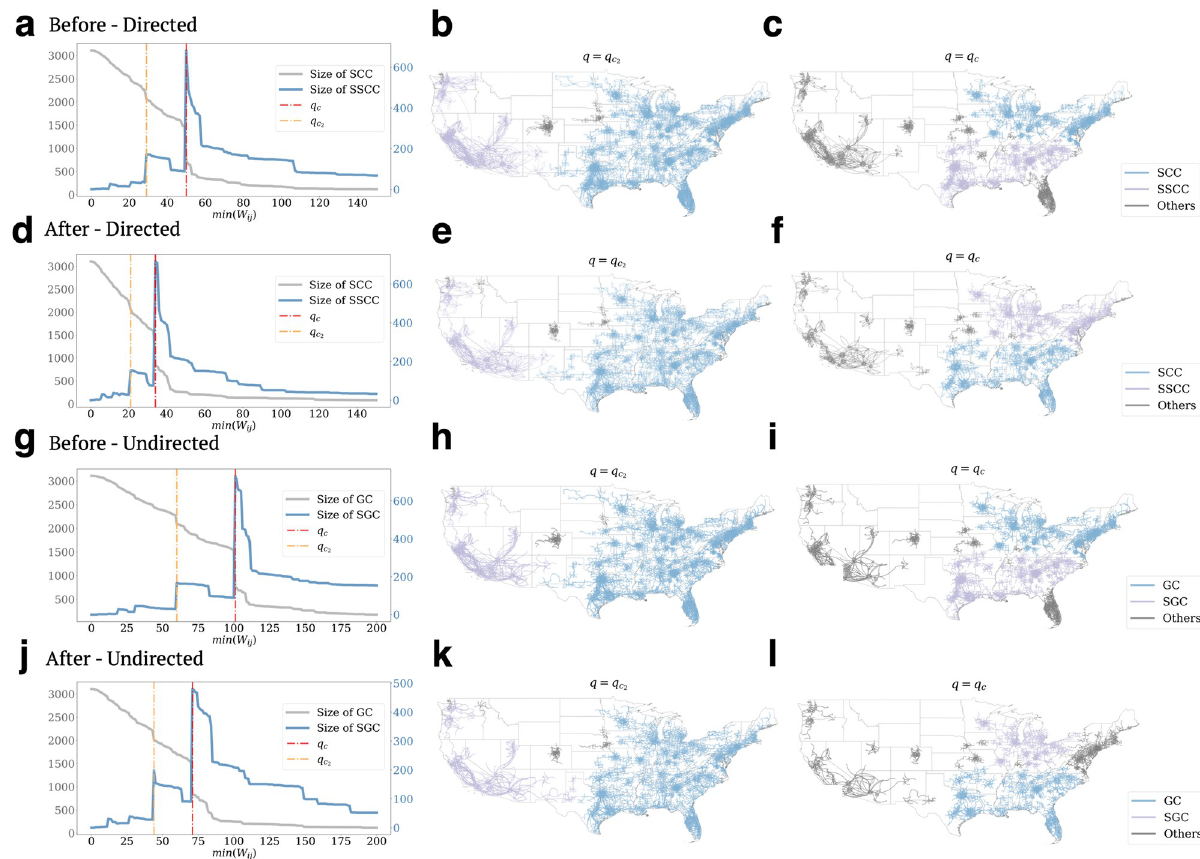
Fig 3. Percolation of mobility networks. a shows the sizes of the largest two components with the change of q in the week of Feb. 10 to Feb. 17, 2020. There are two critical thresholds: q at which SSCC experienced the largest size increase and q at which the size of SSCC reached the second largest c c 2 peak. The networks at two thresholds are shown in b and c respectively. We show the top three sub-components, size-wise, which are in blue (largest), purple (second-largest) and grey (fourth-largest) at both thresholds if they exist. d , e and f are the percolation directed networks in the week of Mar. 30 to Apr. 6, 2020. g-i demonstrate similar percolation patterns for the same week of data before National Emergency using undirected graphs where g highlights the similar percolation phenomenon; The undirected graph results after the mobility perturbation are shown in j-l and we can observe that across all scenarios at q , a large sub-component on the west coast states detached from the network while at q at least three major sub-components are c 2 c separated. These large clusters are similar despite the decrease of the value of q c after Mid